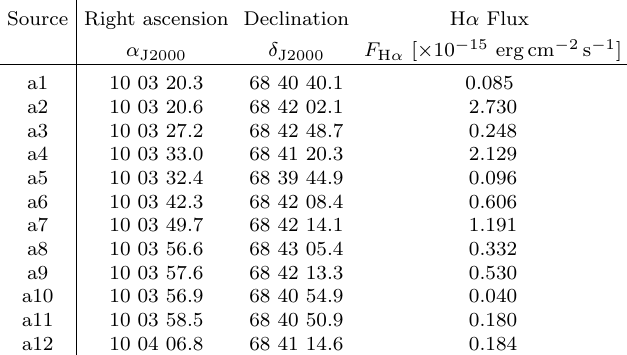
Table 3. New H II region candidates in